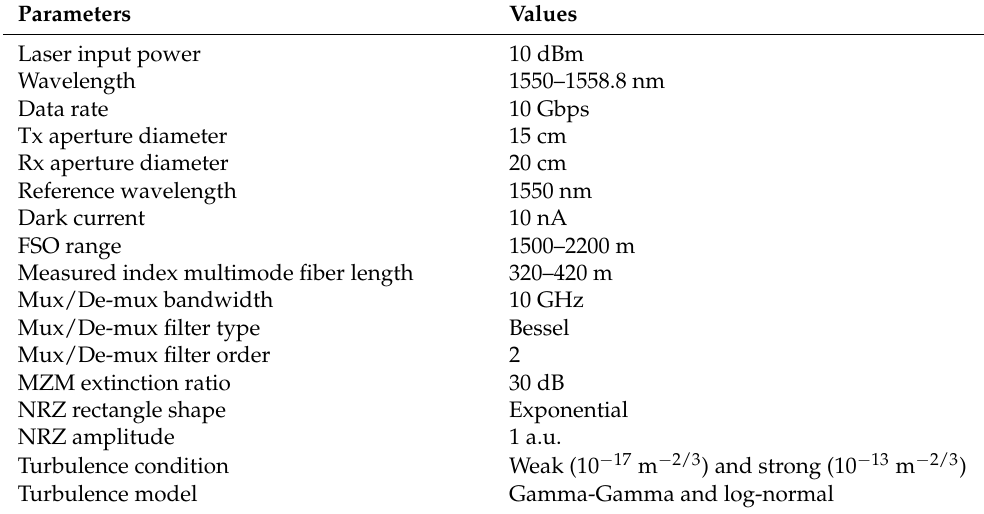
Table 3. Parameter values for MDM-based FSO-OCDMA system.